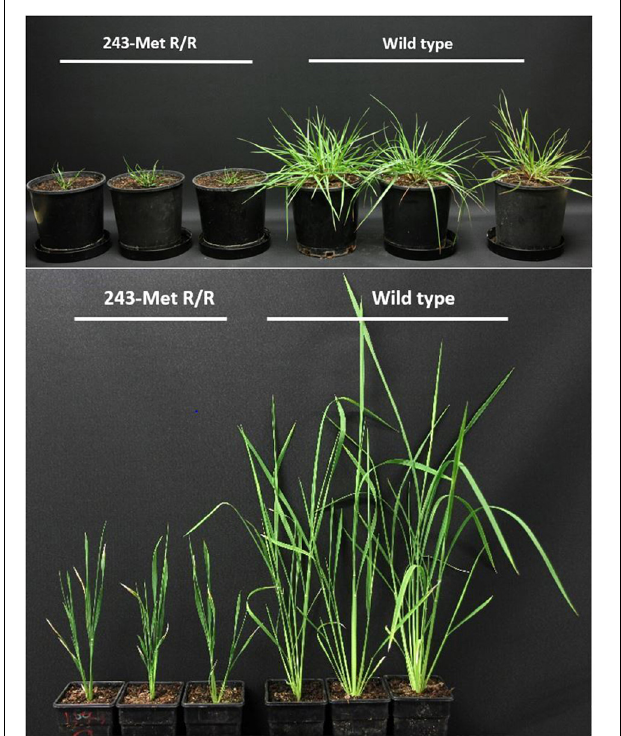
FIGURE 3 | Helical growth of Lolium rigidum (top picture, on the left) and transgenic rice (T2, bottom picture, on the left) homozygous for the α -tubulin Arg-243-Met mutation (243-Met R/R) in comparsion to the norma growth of corresponding wild type plants (on the right). Photos were taken 42 and 30 days after L. rigidum and rice transplanting,